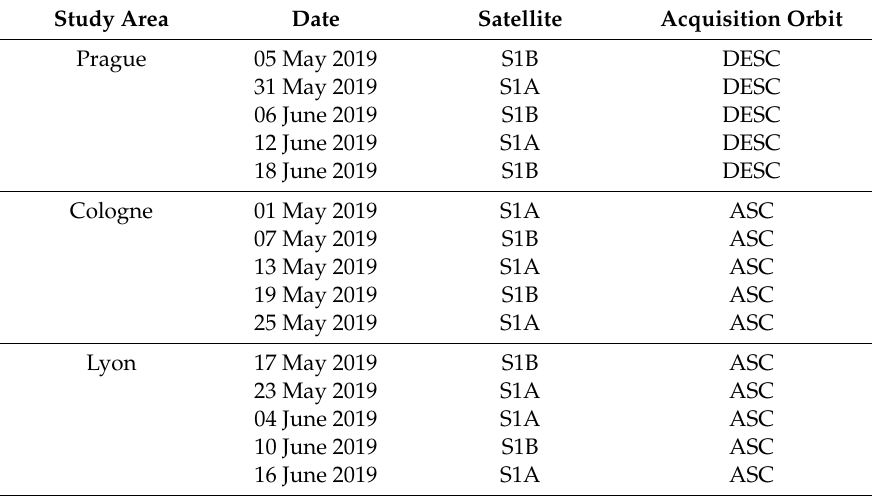
Table 1. Multitemporal S1 imagery used in this research. Study